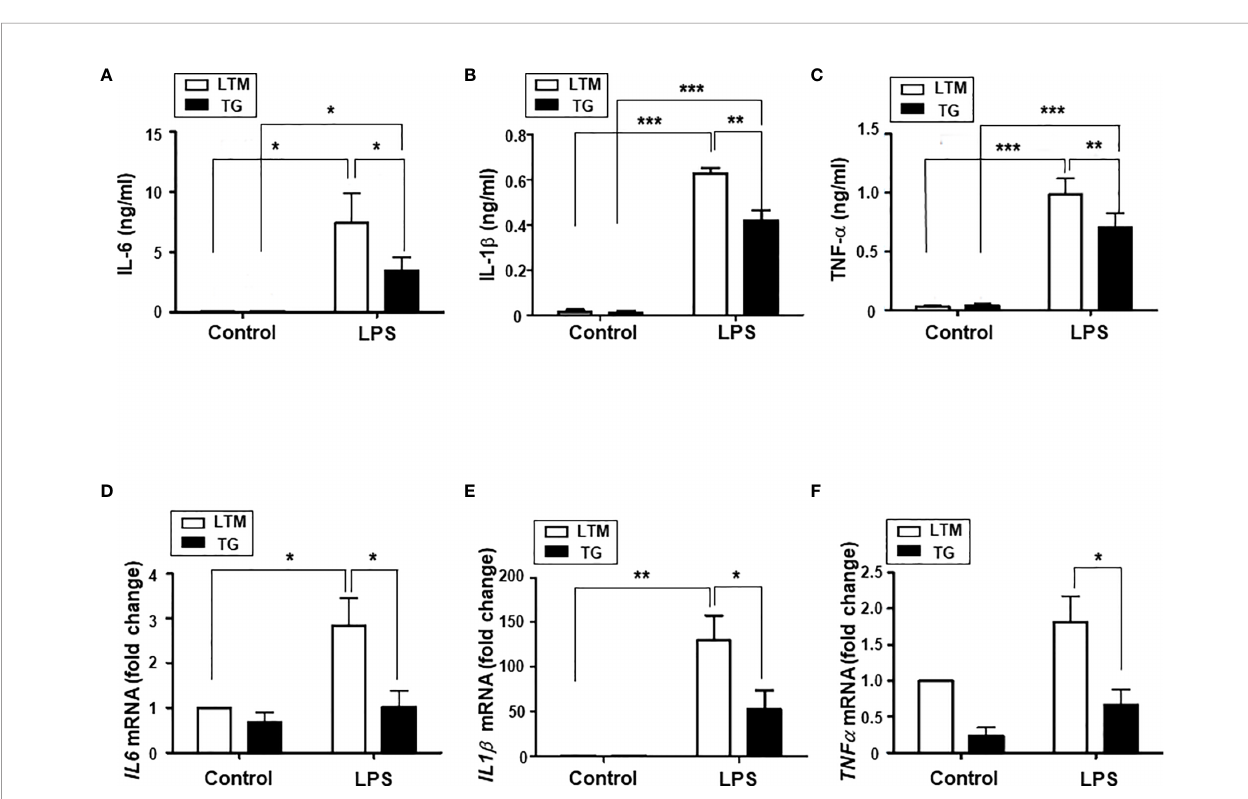
FIGURE 6 | Analyses of in fl ammatory cytokine production in the PMs of LTM and p190RhoGEF TG mice. PMs from LTM control and TG mice were cultured in the medium alone (control) or with LPS (100 ng/ml) overnight. For IL-1 b ELISA, cells were stimulated with ATP (2 mM) for 1 hour after 3-hour LPS (100 ng/ml) treatment. (A – C) The levels of IL-6, IL-1 b , and TNF- a in the supernatants were compared by ELISA. The data are the mean ± SEM of three independent experiments with triplet sample settings. Statistical signi fi cance was analyzed by one-way ANOVA with Tukey ’ s multiple comparison tests. Signi fi cant comparisons are noted as * p < 0.05, ** p < 0.01, *** p < 0.001. (D – F) Messenger RNA transcripts of IL-6, IL-1 b , and TNF- a were compared by quantitative real- time PCR analysis, as described in Materials and Methods. The relative level of expression is shown compared with the expression level of LTM control PM cells. Data are the mean ± SEM of four separate experiments. Signi fi cance was determined by one-way ANOVA with Tukey ’ s multiple comparison tests. Signi fi cant comparisons are noted as * p < 0.05, ** p <